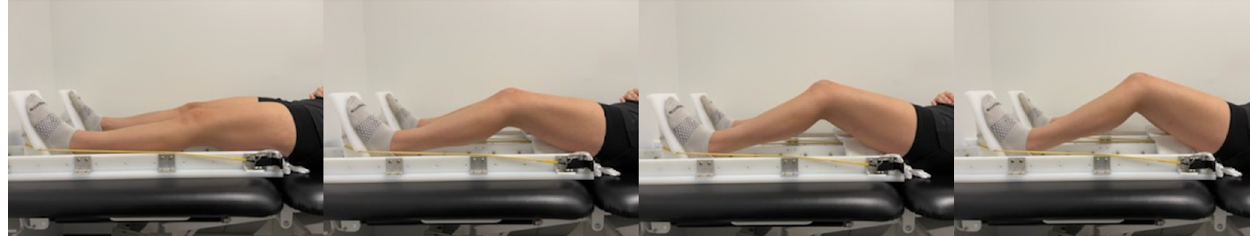
Fig 1. Participant positioning to complete the bilateral leg press neuroimaging